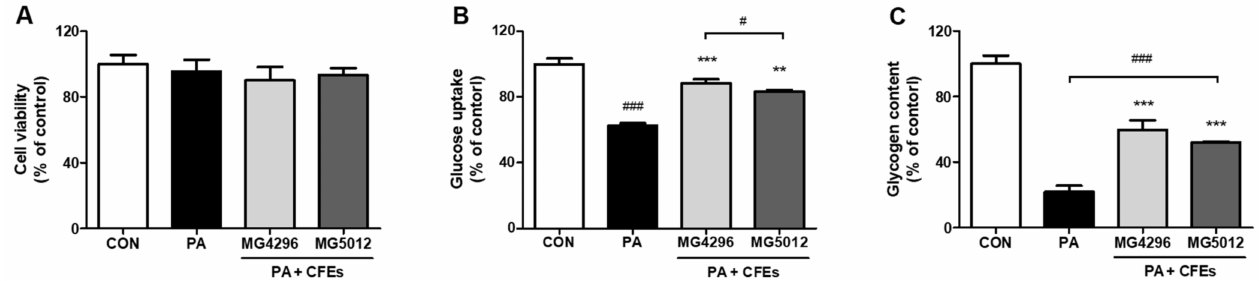
Figure 1. Effect of MG4296 and MG5012 on ( A ) cell viability, ( B) glucose uptake, and ( C ) glycogen contents in insulin resistant-induced HepG2 cells by palmitic acid. Data are presented as mean ± SD ( n = 3). ** p < 0.01, *** p < 0.001 vs. CON cells, and # p < 0.05, ### p < 0.001 vs. PA-treated cells.